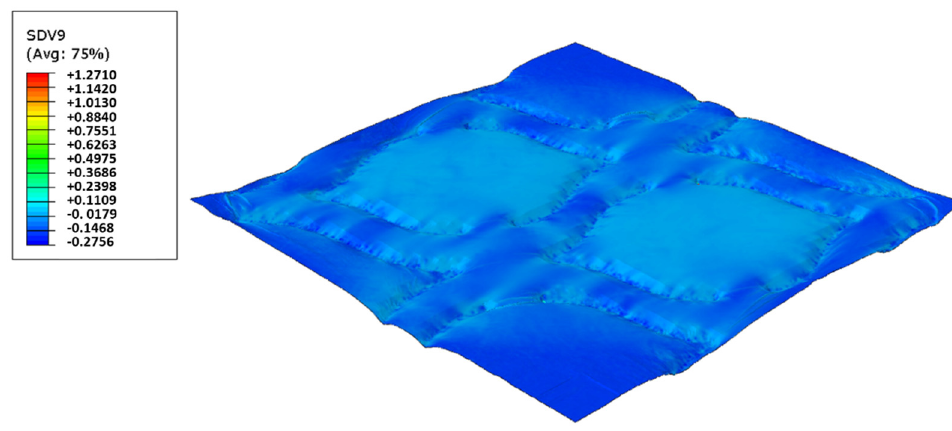
Figure 24. Deco die 60_48 Sh-A (SBR PR/NR BG), Plastic field.